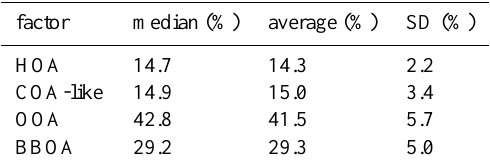
Table 3. Median and average factor contributions over all 15 partic- ipating